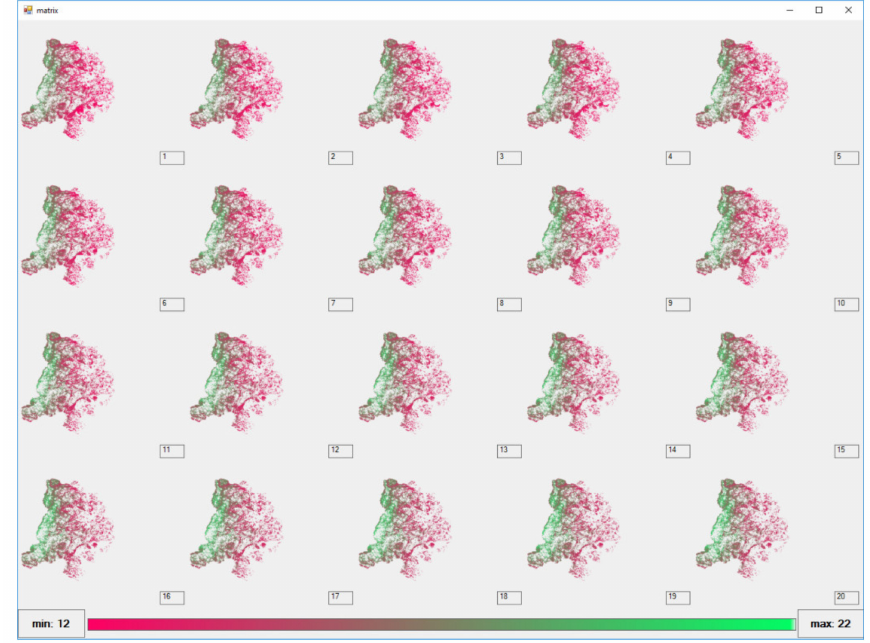
Figure A5. Price distribution for Scenario 1 (Biomass I (B1), felling) over a period of 20 years (t 1 to t 20 ) in the Nordeste region, Portugal. The minimum price was 12 € / m 3 (light red) and the maximum 22 € / m 3 (light green).